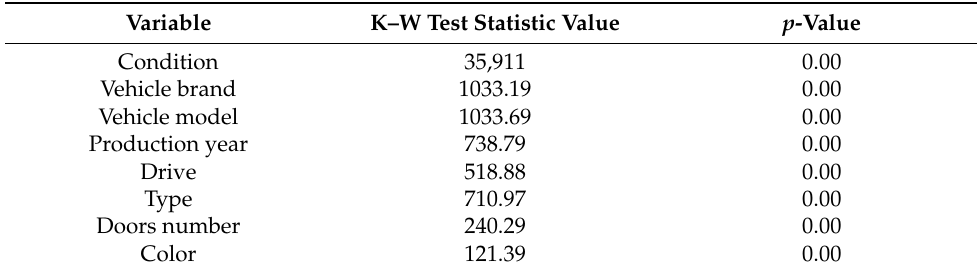
Table 3. Kruskal–Wallis test